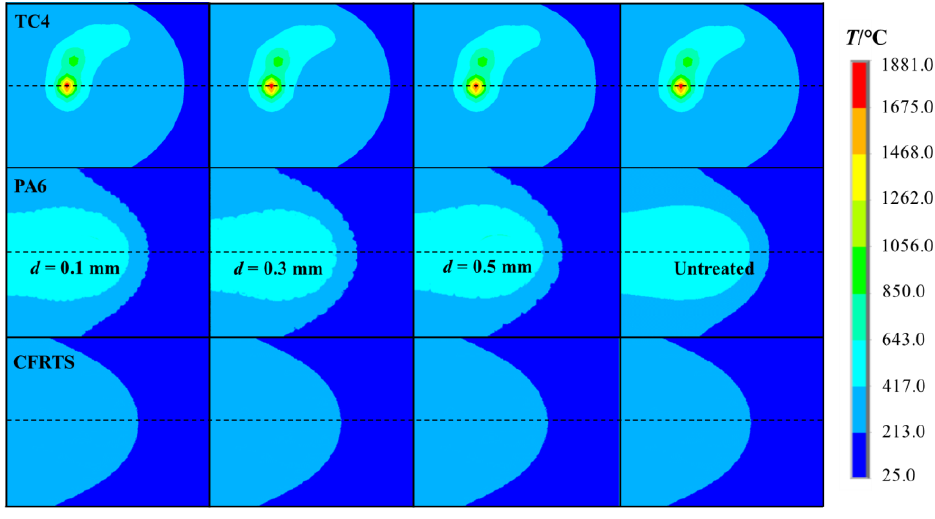
Figure 10. Comparison of the temperature fields of finite element models in each group.